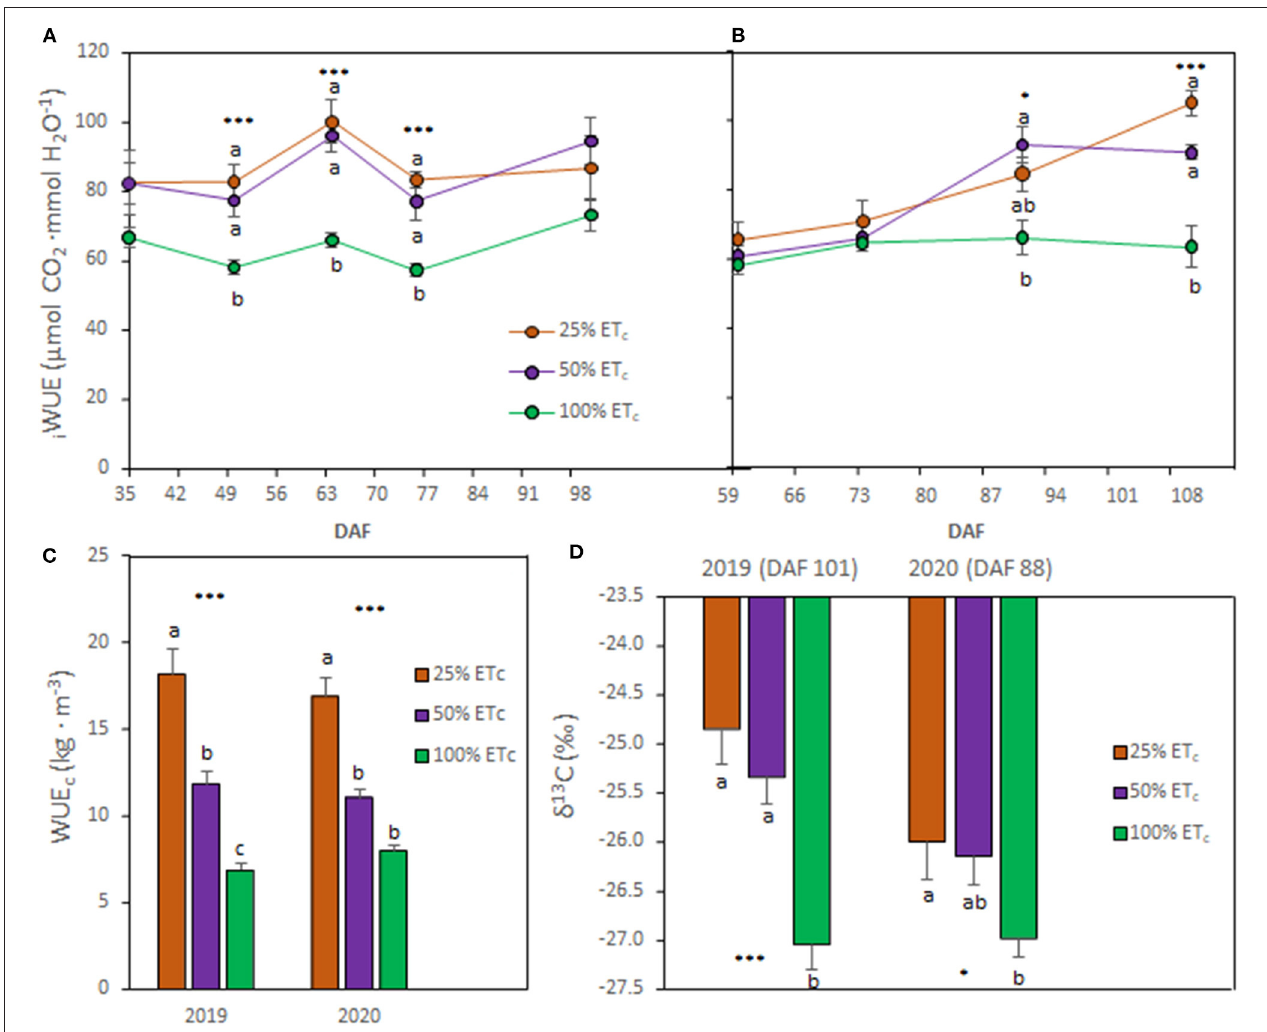
FIGURE 2 | Intrinsic water use efficiency (iWUE, A and B ), crop WUE (WUE c , C ), and δ 13 C of berry must (D) of Cabernet Sauvignon grapevines (clone FPS08), subjected to different replacements of crop evapotranspiration (25, 50, and 100% ET c ) and collected through 2018–2019 and 2019–2020 growing seasons in Oakville, CA. Values represent means ± SE ( n = 6). At each time point, different letters indicate significant differences ( p ≤ 0.05) between irrigation treatments according to one-way ANOVA followed by Tukey HSD test. *, and *** indicate significance at 5, and 0.1% probability levels, respectively. DAF, Days after